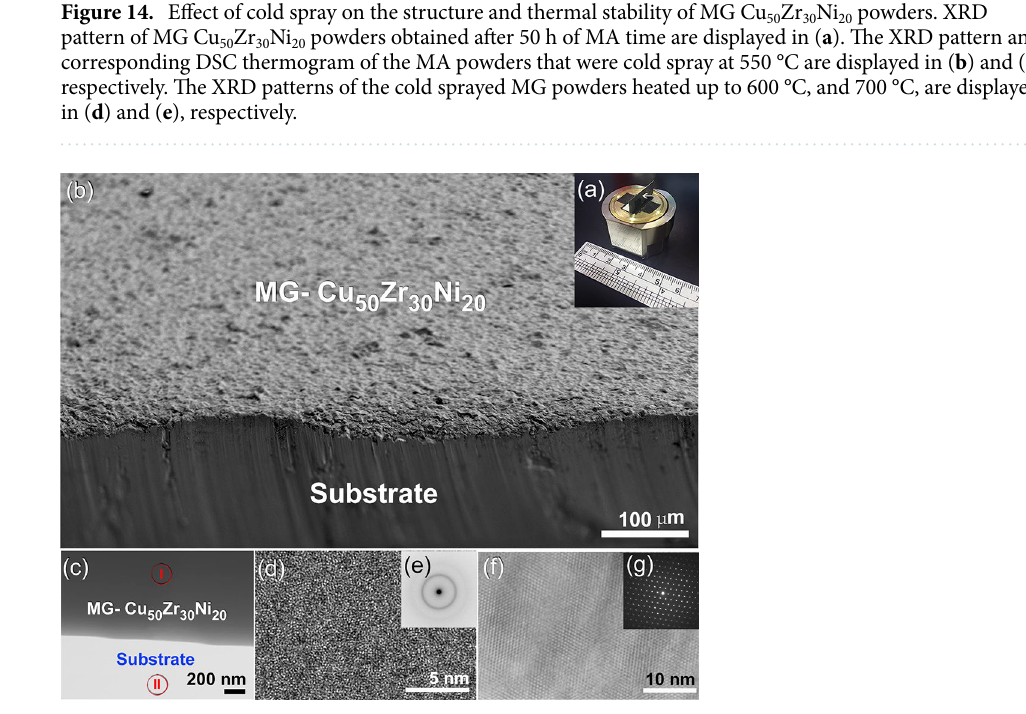
Figure 15. A typical MG-Cu 50 Zr 30 Ni 20 coated/SUS304 sample, which was vertically mounted on Cu-SEM sample holder ( b ) is displayed in figure ( a ). The STEM micrograph for the ion polished samples is displayed in ( c ). In the meanwhile the FE-HRTEM of Zone I and Zone II indexed in ( c ) are displayed in ( d ) and ( f ) together with their NBDPs ( e , g ), respectively. The FE-SEM image of the plan view of this sample is shown in ( b